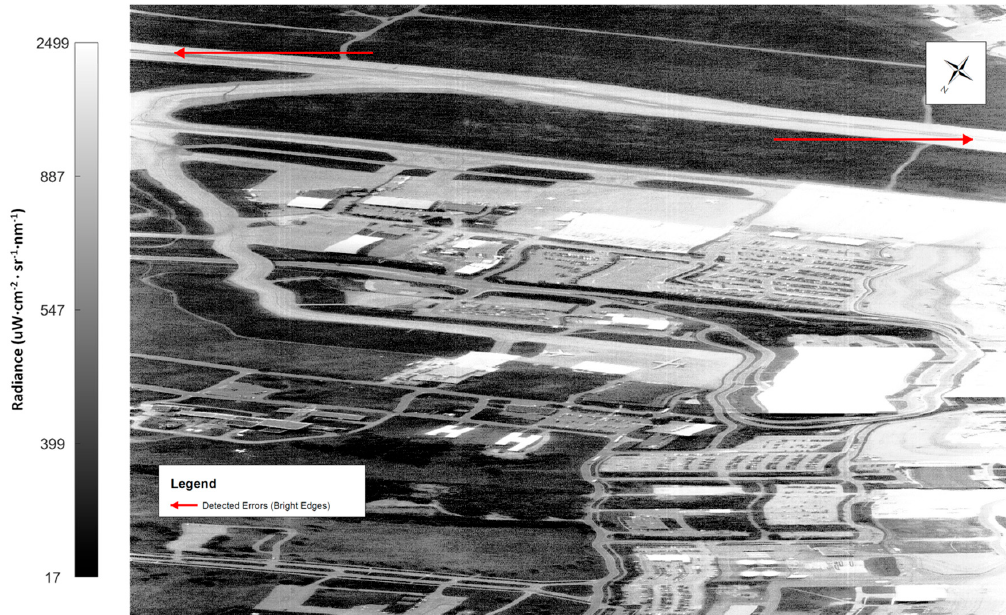
Figure 14. Histogram-equalized CASI image (24 June with the original processing) at 393.068 nm. The asphalt road along the south side of the image was brightest along the edge pixels. The errors in the data are highlighted by the red arrows.